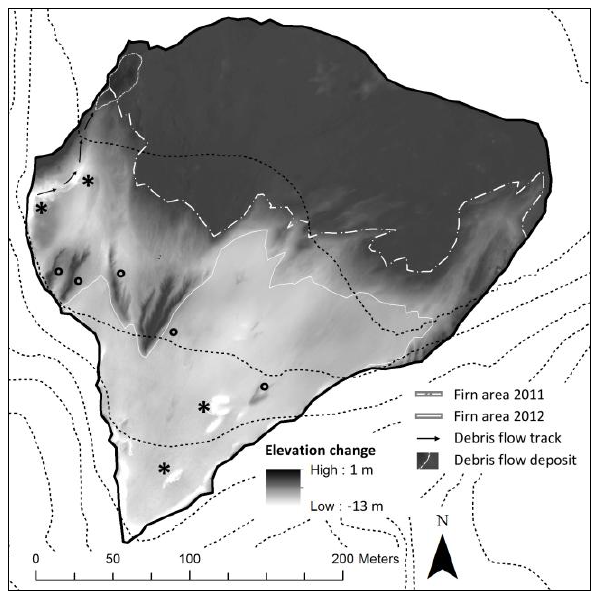
Figure 2. Elevation changes measured from a) September 2010 Figure 3. Elevation changes vs. elevation from September 2010 to May 2011, b) September 2010 to September 2011, c) to September 2011 (black line) and from September 2011 to September 2011 to May 2012 and d) September 2011 to October 2012 (grey line) along the profile SW-NW in Figure October 2012. Digits represent elevation changes for each 2a. period.